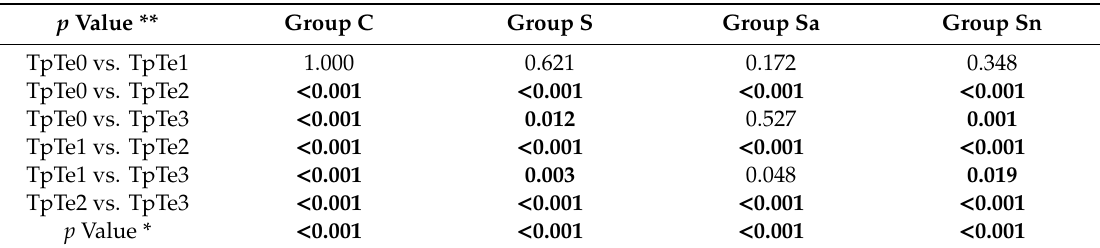
Table 5. Inter-time comparison of TpTe intervals in ECGs on admission to hospital and during three phases of HUTT.